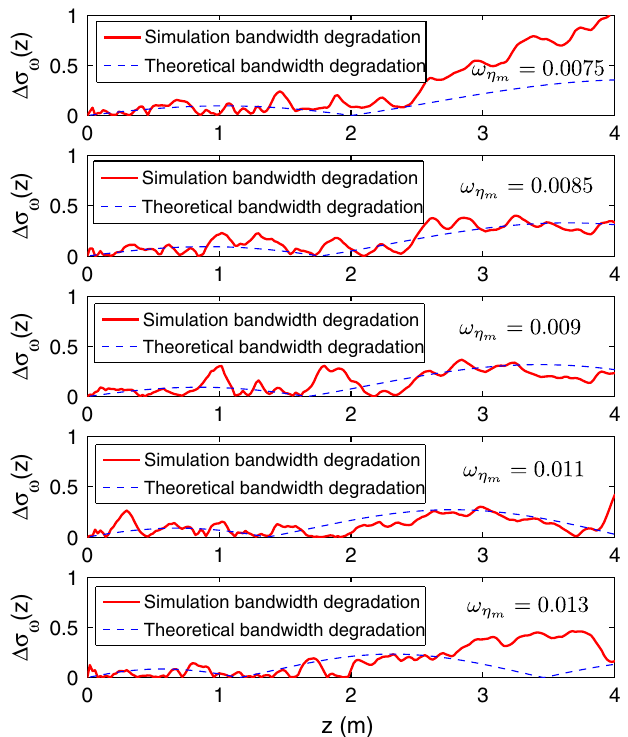
FIG. 7. (Color) Bandwidth degradation for different ! simulation parameters are listed in Table I. The initial bunch energy modulation frequency !